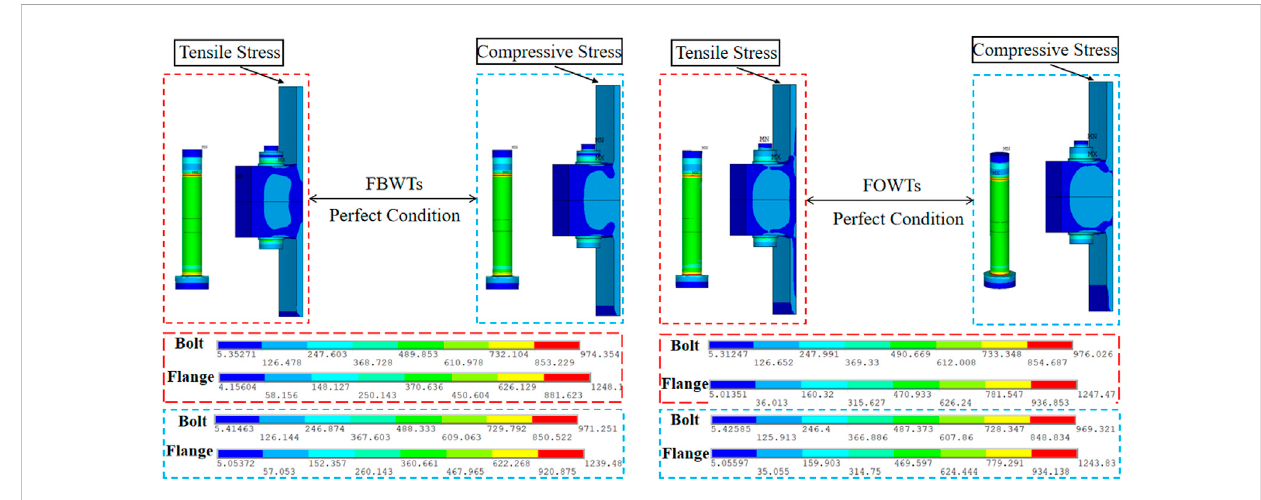
FIGURE 9 Von Mises stress state of the OWTs ’ tower fl ange under the perfect